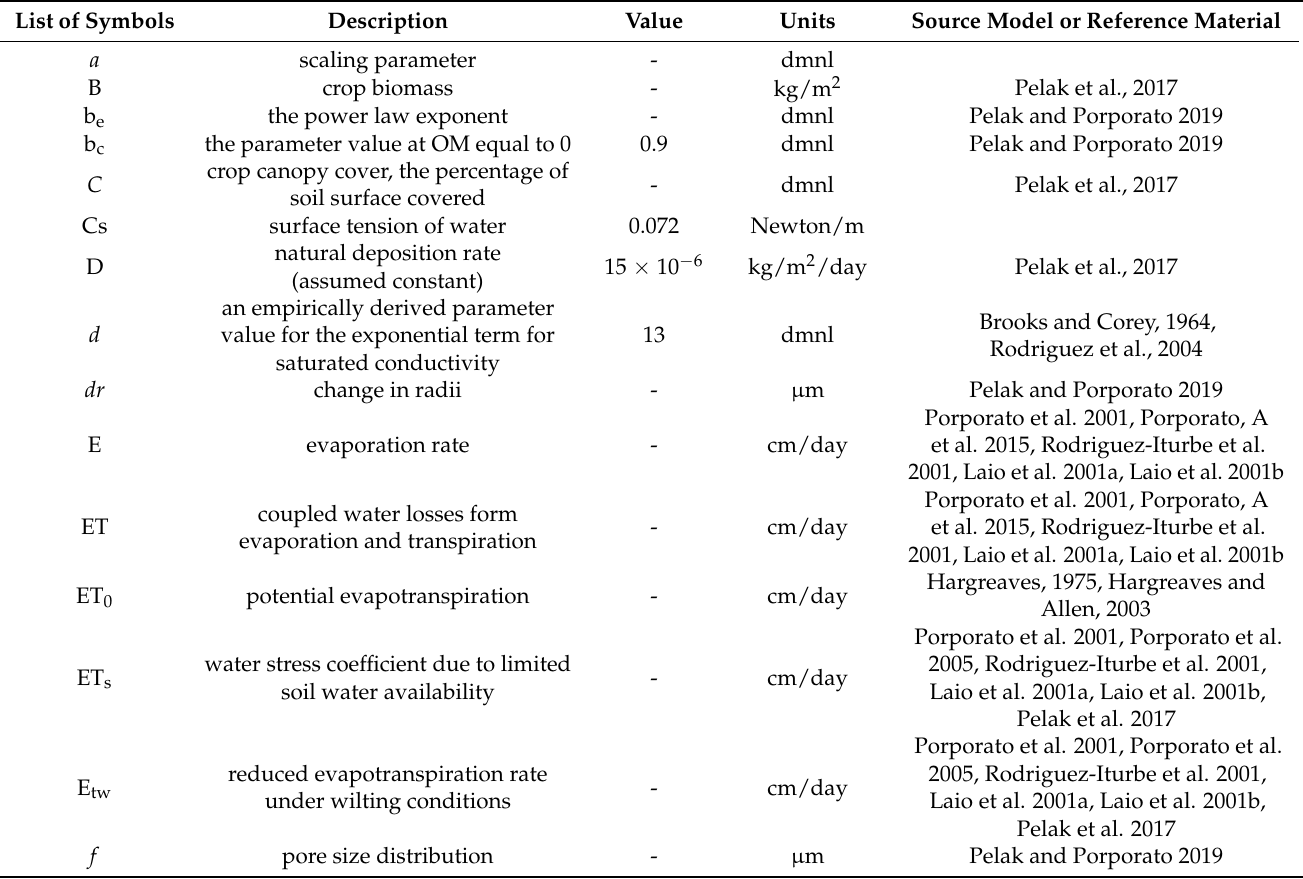
Table A1. Summary of key parameter symbols used throughout the text, including description of the parameter, its value (if a constant) and units, and scientific source from which it was replicated (if